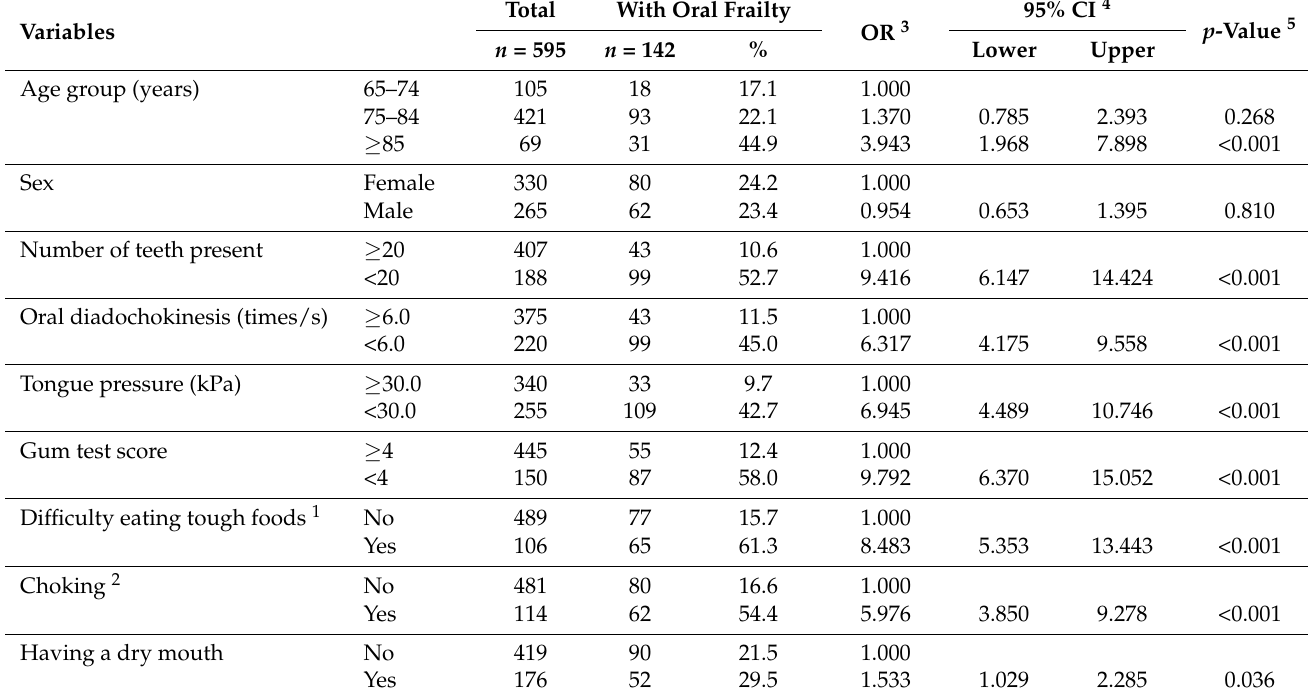
Table 2. Association of age, sex, and each characteristic of oral frailty with oral frailty in the training set.